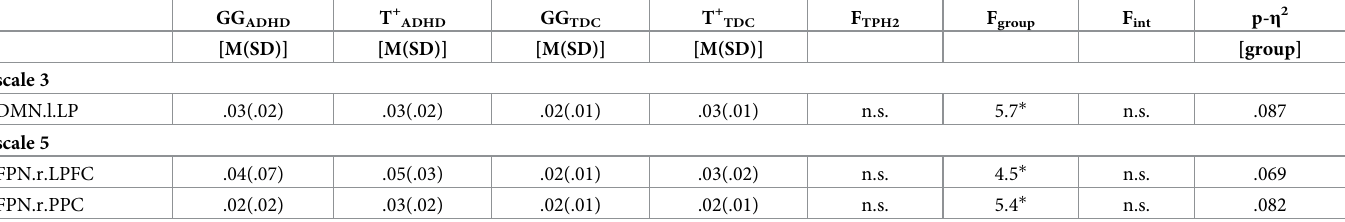
Table 3. Significant results of 2x2 MANOVA models using TPH2 genotype and group , and ROI- and scale-specific wVar. GG